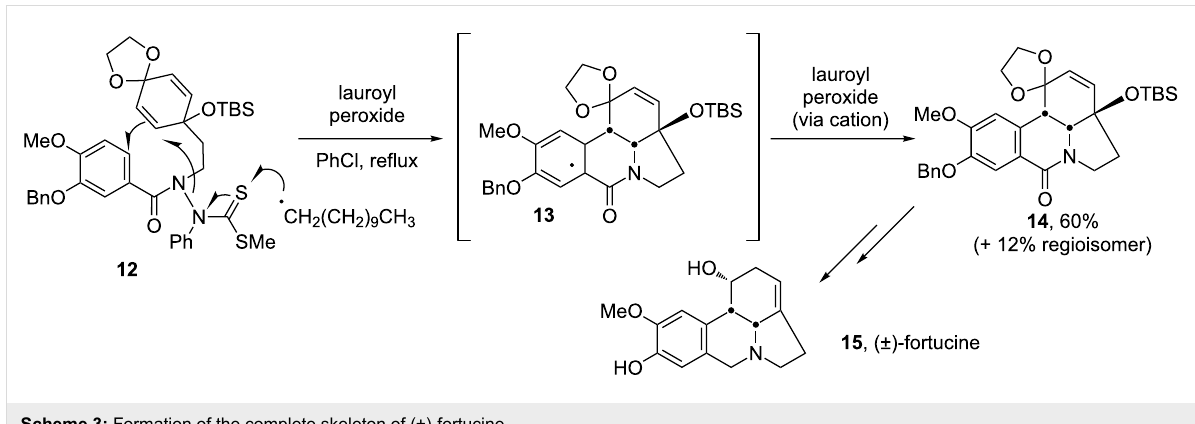
Scheme 3: Formation of the complete skeleton of (±)-fortucine.